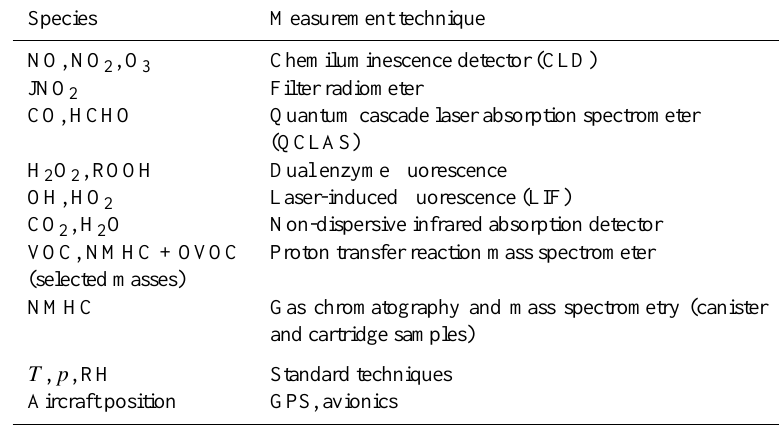
Table 1. Compendium of the measured species during the GABRIEL